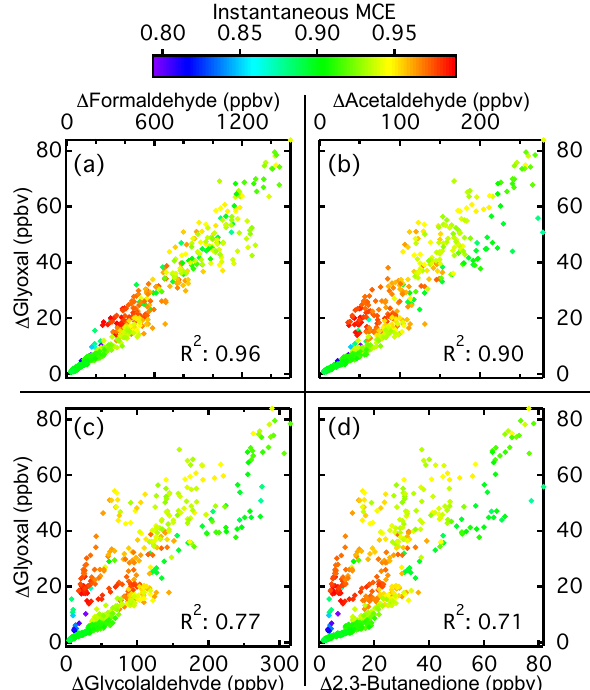
Figure 6. Correlation plots for glyoxal relative to four other car- bonyls for Fire 027 (chamise chaparral). Shown are the plots for gly- oxal versus formaldehyde (a) , acetaldehyde (b) , glycolaldehyde (c) , and 2,3-butanedione (d) . The markers are colored by instantaneous MCE. Correlation plots for acetone and hydroxyacetone are similar to the plots for glycolaldehyde and